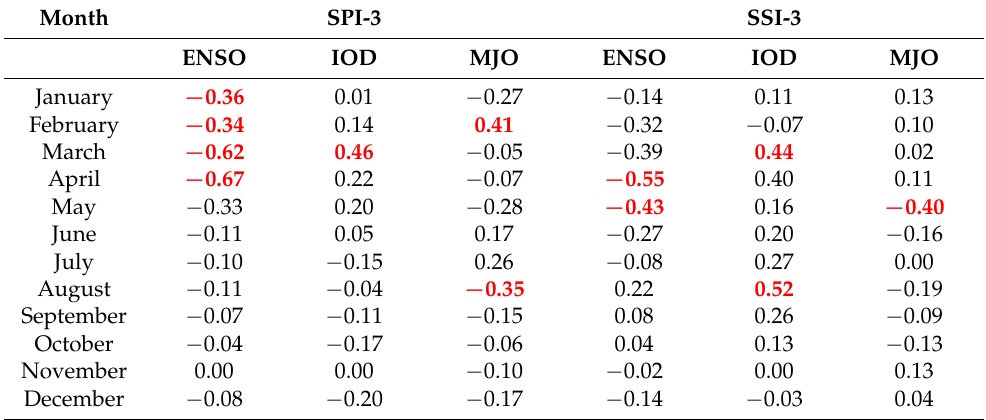
Table 6. Correlations between ENSO, MJO, and IOD with drought indices (red bold indicates a significant correlation at a 95% confidence